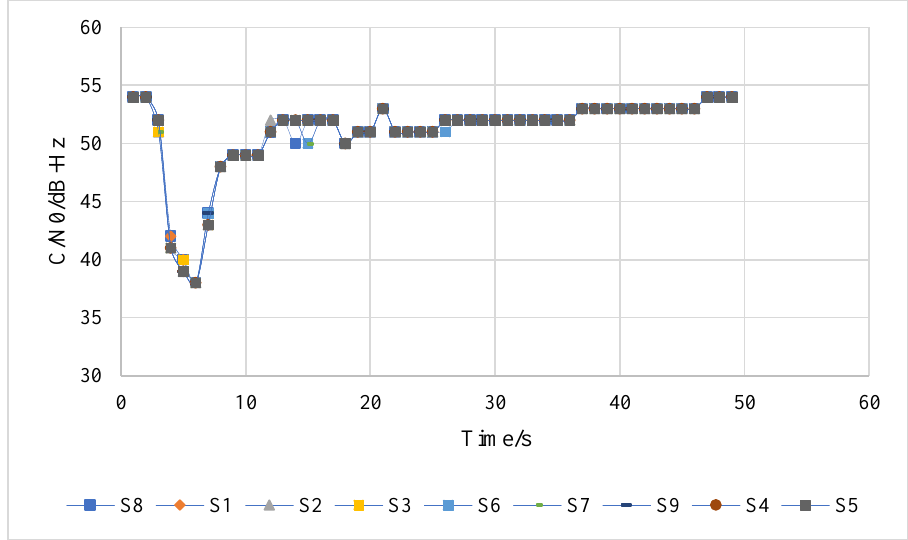
Figure 1. The process of C/N0 recovery when the interference is at working frequency